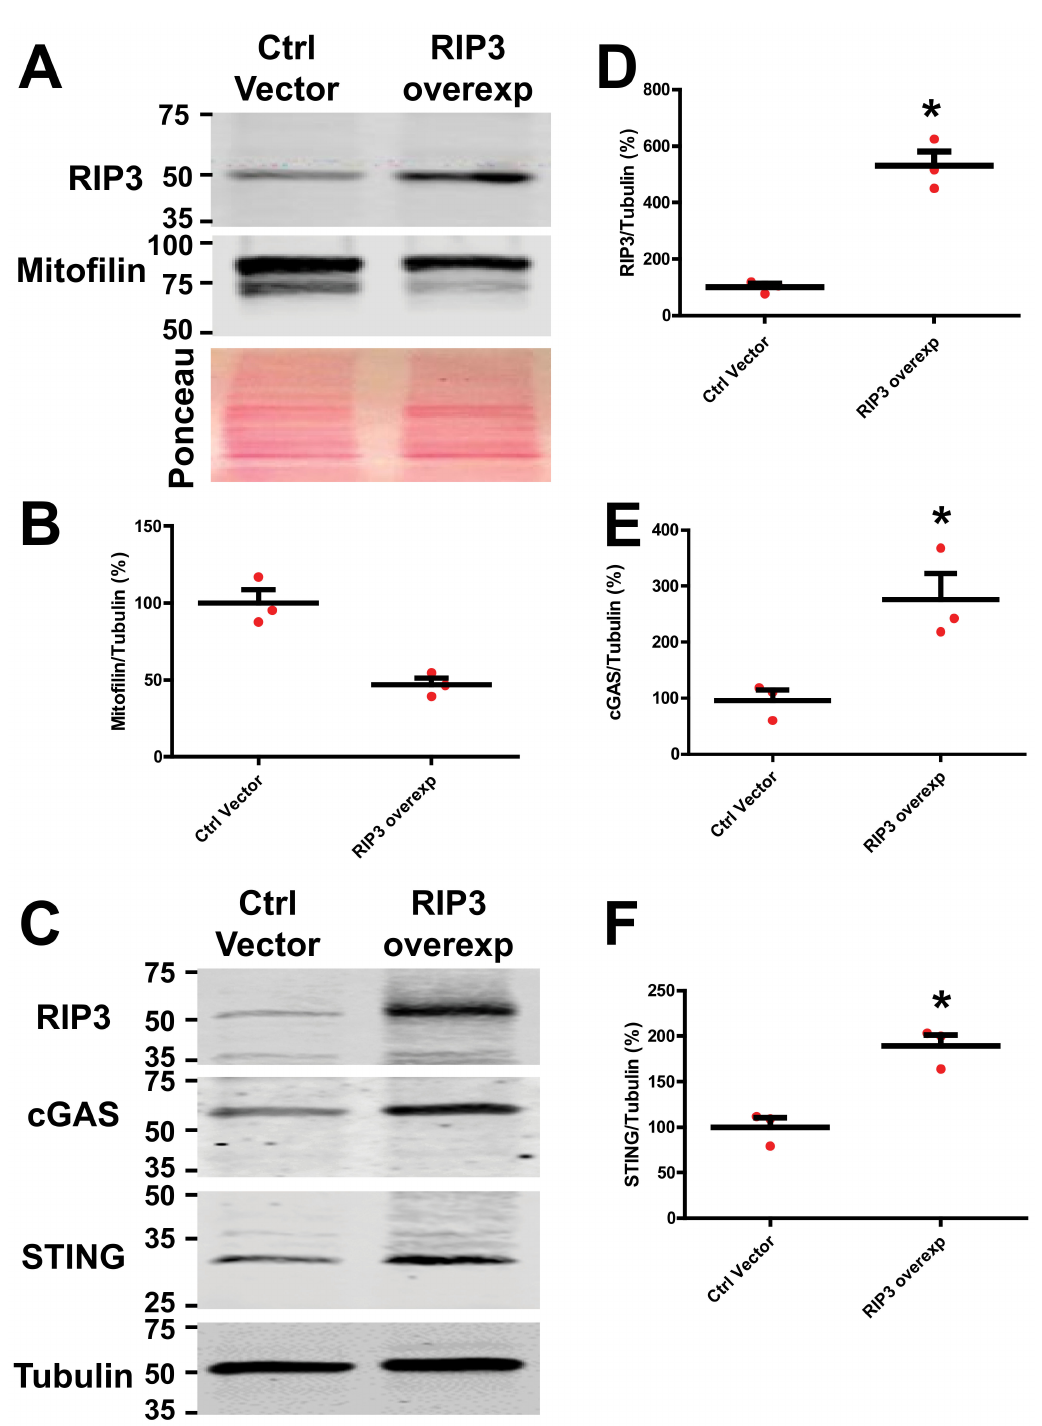
Figure 8. RIP3 overexpression in HK-2 cells increases the levels of cGAS and STING and reduces Mitofilin levels. ( A ) Immunoblots and graph ( B ) showing reductions in Mitofilin levels in HK-2 cells transfected with an RIP3-overexpressed plasmid compared to those transfected with pCMV6 control vector. ( C ) Immunoblots showing increases in the levels of cGAS and STING levels in HK-2 cells transfected with an RIP3-overexpressed plasmid compared to those transfected with pCMV6 control vector ( D – F ). Graph showing increases in the levels of RIP 3 ( D ), cGAS ( E ), and STING ( F ) in HK-2 cells transfected with an RIP3-overexpressed plasmid compared to those transfected with pCMV6 control vector. Values are expressed as means ± SEM; * p < 0.05 versus control (Ctrl) vector group ( n =